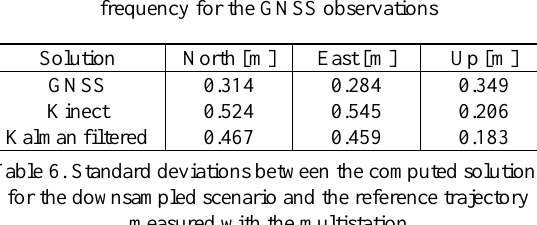
Figure 10. The computed solutions simulating a 0.1 Hz frequency for the GNSS observations